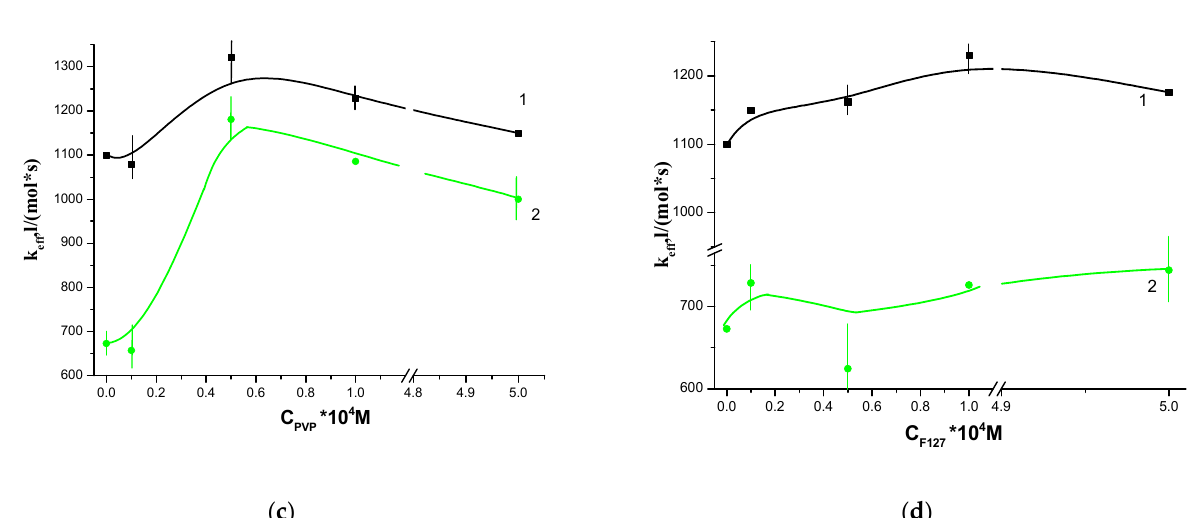
Figure 4. Dependence of the effective rate constant of tryptophan photo-oxidation, catalyzed by the ternary systems photosensitizers- amphiphilic polymers-chitosan (PS-AP-CT) on the concentration of AP, where PS = dimegin (DMG) ( a , b ), Ce6 ( c , d ). Where, AP-polyvinylpyrrolidone (PVP) ( a , c ), F127 ( b , d ). C CT100 = 0 (curve 1); C CT100 = 10 − 4 M (curve 2); C CT100 = 6 × 10 − 4 M (curve 3); C CT100 = 10 − 3 M (curve 4); C CT100 = 6 × 10 − 3 M (curve 5). The concentration of porphyrin is C = 5 × 10 − 6 M, the concentration of tryptophan is 10 − 4 M.